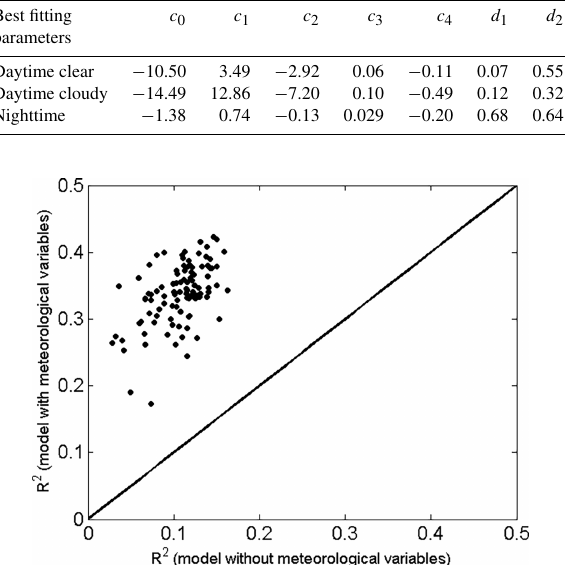
Figure 2. Same as Fig. 1 but just for cases under daytime cloudy conditions.